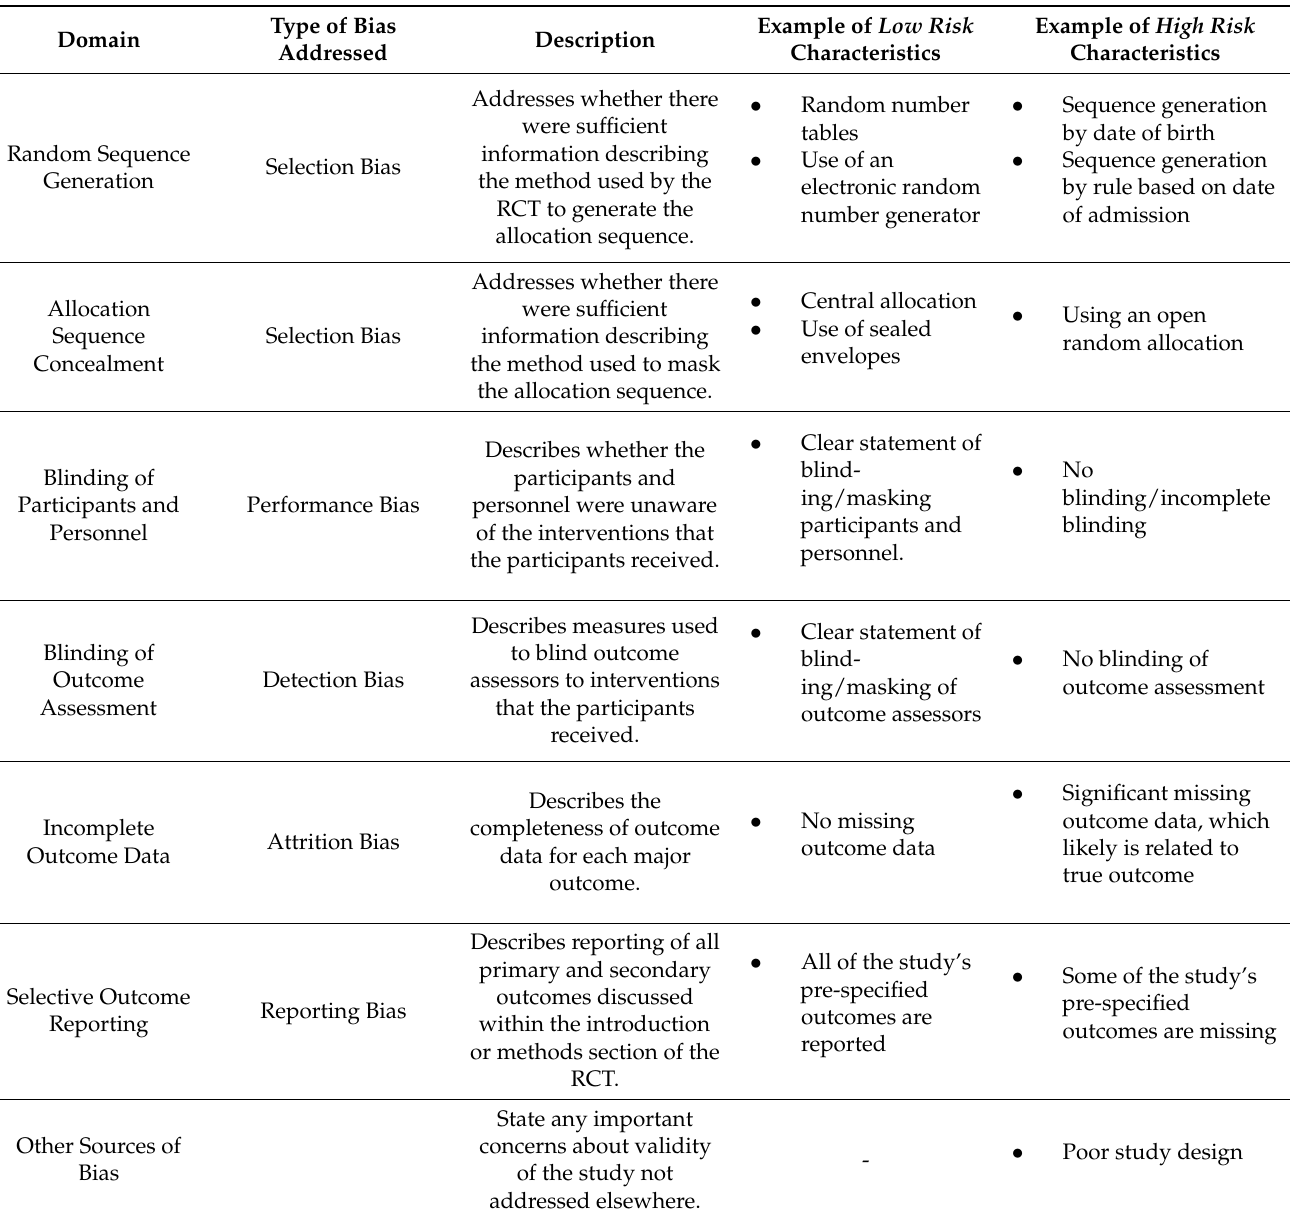
Table 1. Description and examples of the Cochrane Collaboration’s seven domains